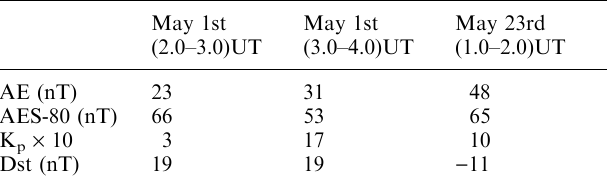
Table 3. Average values for AE, AES-80, Kp and Dst during the indicated one hour intervals